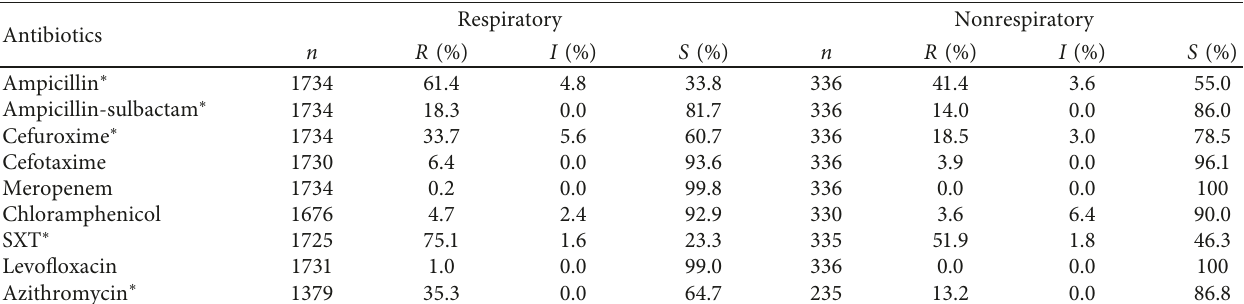
Table 3: Antibiotic resistance rates of respiratory and nonrespiratory isolates of Haemophilus influenzae